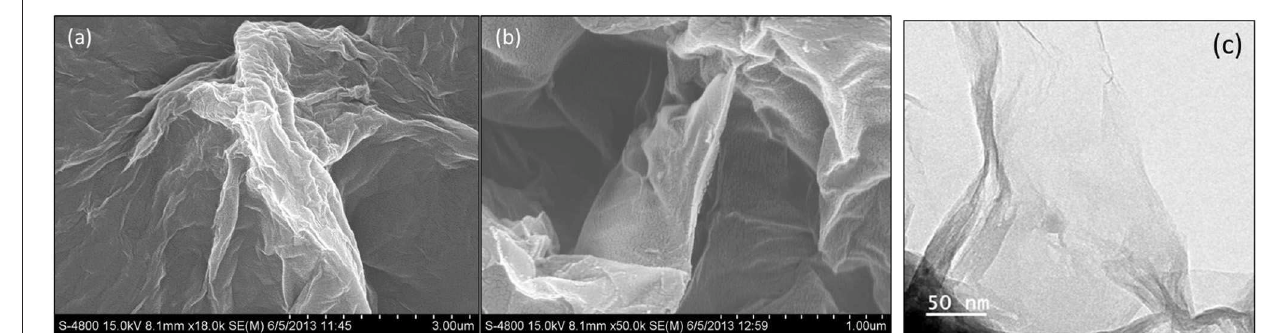
FIGURE 2 | FE-SEM image of (a) GO and (b) rGO, and (c) TEM image of GO.